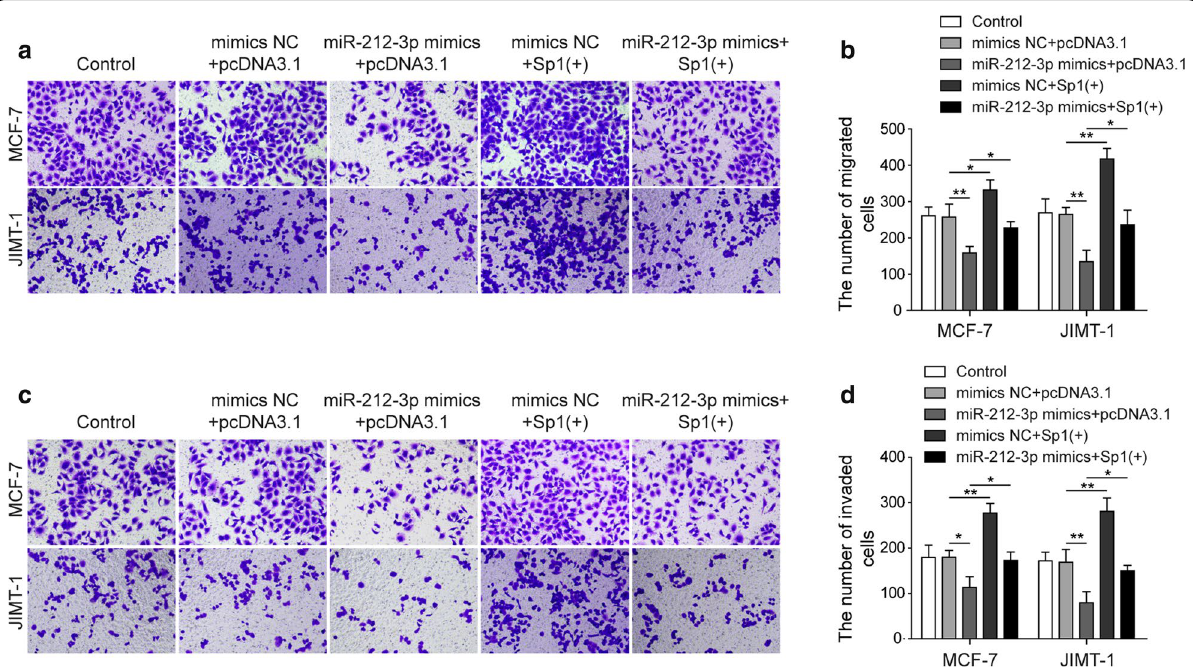
Fig. 4 MiR‑212‑3p inhibited the migration and invasion of BC cells by reducing the expression of VEGFA through SP1. a , b Migration of MCF‑7 and JIMT‑1 was detected by transwell in cells transfected with miR‑212‑3p mimics and Sp1 ( transwell in cells transfected with miR‑212‑3p mimics and Sp1 (